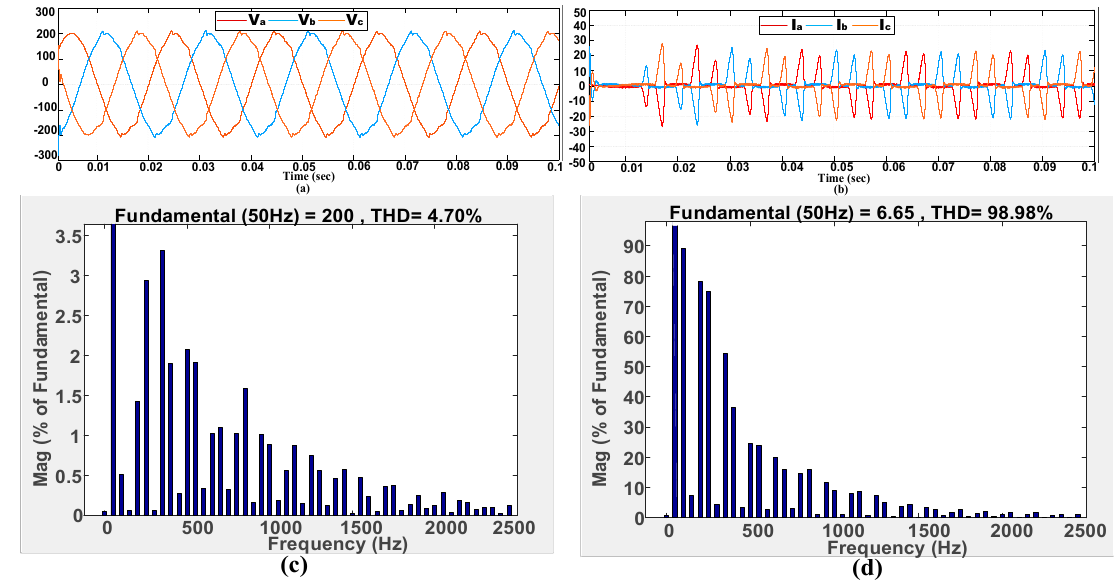
Figure 10. Simulation results with the DB predictive controller in steady-state condition. ( a ) Output voltage, ( b ) Load current, ( c ) THD value of voltage, ( d ) THD values of current.